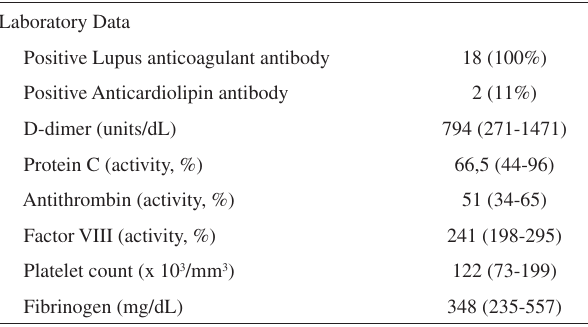
Table 2 - Laboratory parameters in critically ill cancer pa- tients with antiphospholipid